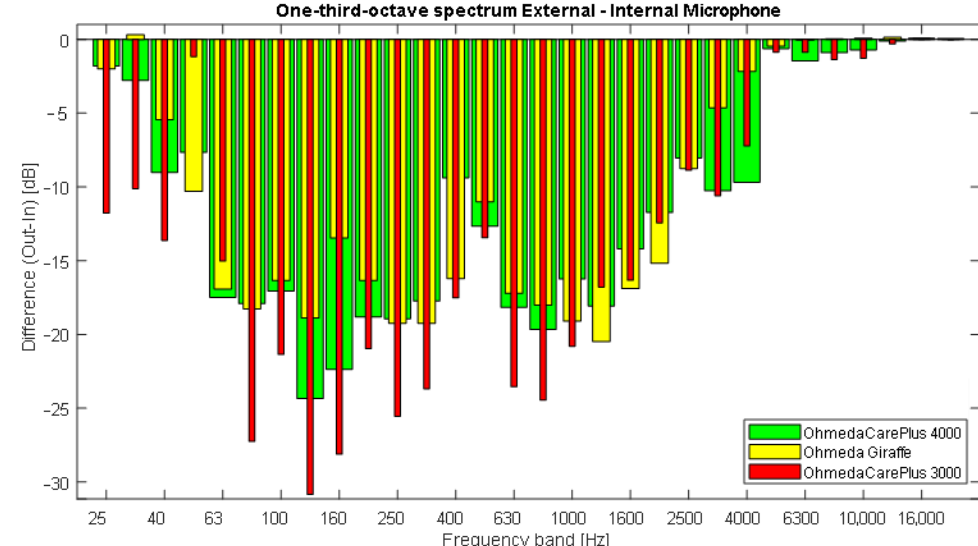
Figure 2. Incubators on: spectral difference between outside and inside the incubator (dB).